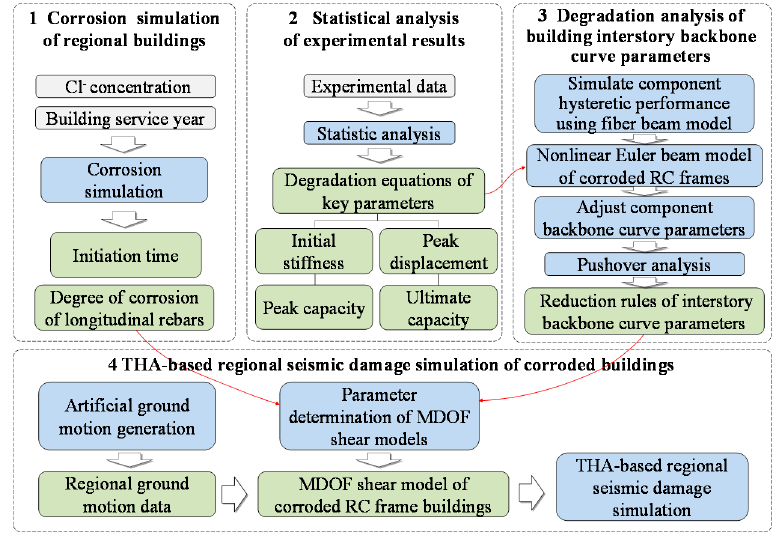
Figure 3. Framework of regional seismic damage simulation for corroded reinforced concrete (RC) frame structures.